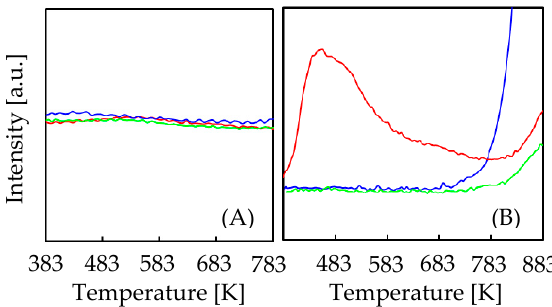
Figure 6. NH 3 -TPD ( A ) and CO 2 -TPD ( B ) spectra of Ag(56)-Na(1) / CaCO 3 , Ag(56)-Na(1) / SrCO 3 and Ag(56)-Na(1) / MgCO 3 indicated by blue, green, and red lines, respectively.